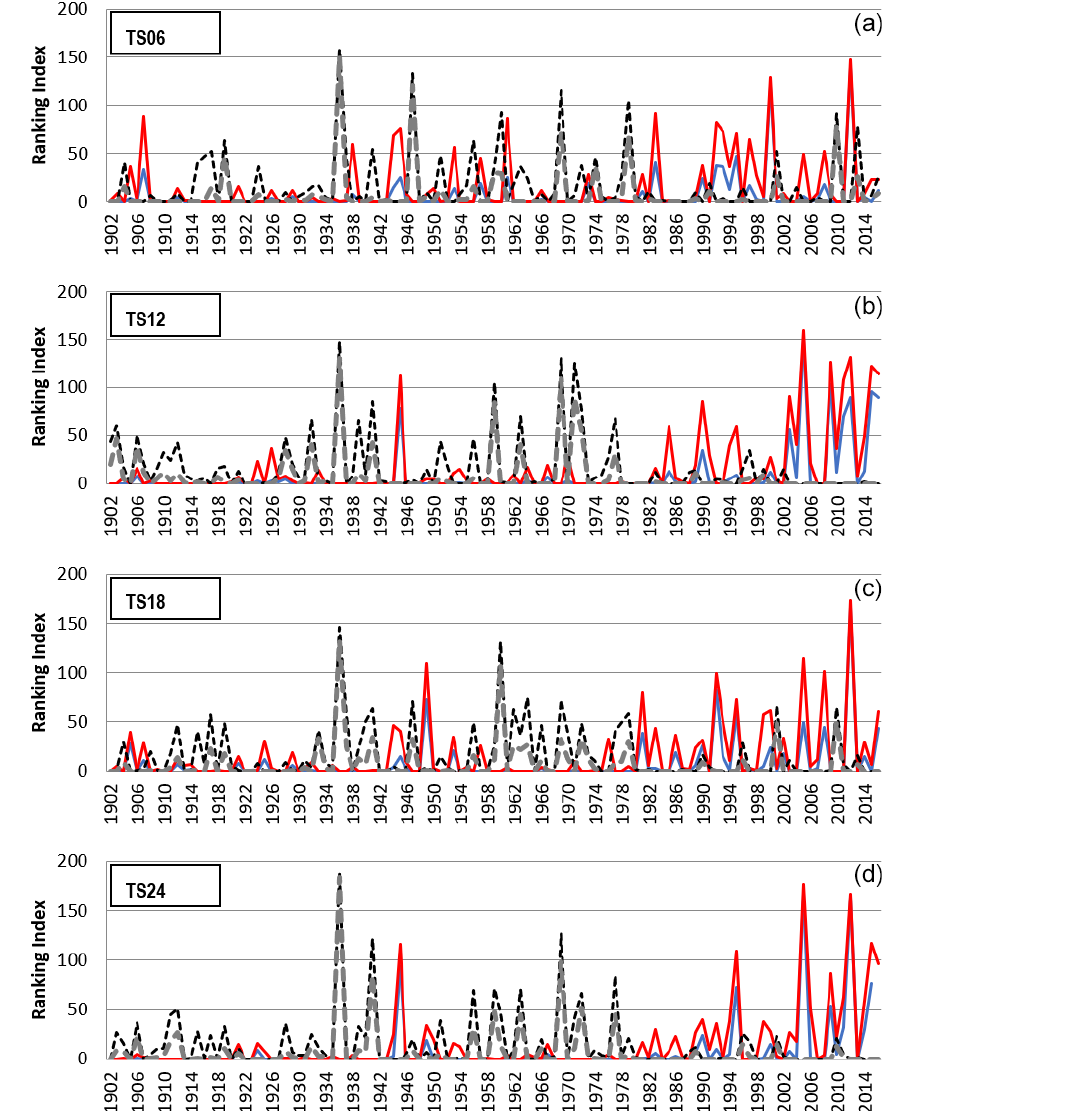
Figure 3. Time evolution of (a) agricultural droughts (ranking index obtained from March SPEI at the 6-month timescale), (b) hydrological droughts (ranking index obtained from September SPEI at the 12-month timescale), and (c–d) longer, persistent (ranking indices obtained from March SPEI at the 18-month timescale c and September at the 24-month timescale d ) droughts. The red lines correspond to the ranking indices obtained from severe and extreme droughts (threshold − 1 . 28); the blue lines represent the ranking indices obtained from the most extreme droughts (threshold − 1 . 65). The black and grey lines represent the analogous time evolution of the moist ranking index obtained for each of the timescales (threshold 1.28, black, and 1.65,